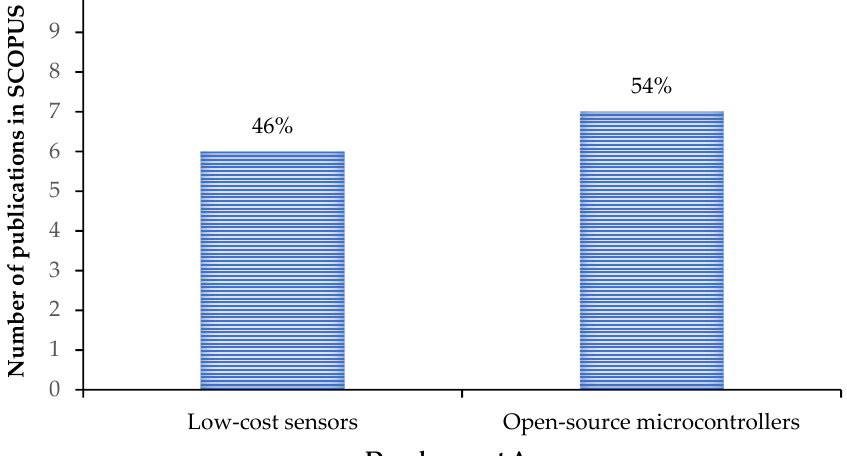
Figure 9. Two areas of development in the SCOPUS database on the application of low-cost corrosion monitoring solutions using the LPR technique: Area 1 focusing on the development of the sensing elements, and Area 2 focusing on the use of open-source microcontrollers as the low-cost data acquisition system.